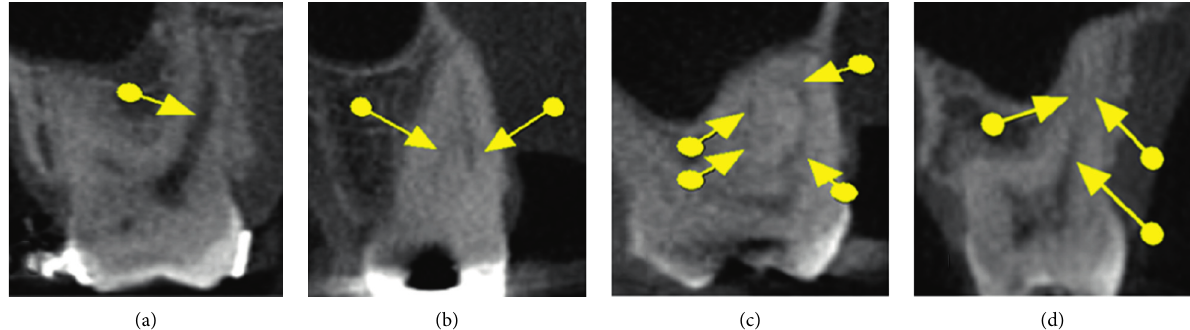
Figure 2: Coronal sections showing the different morphological types proposed by Weine et al. [14], (a) type I, (b) type II, (c) type III, and (d) type IV.